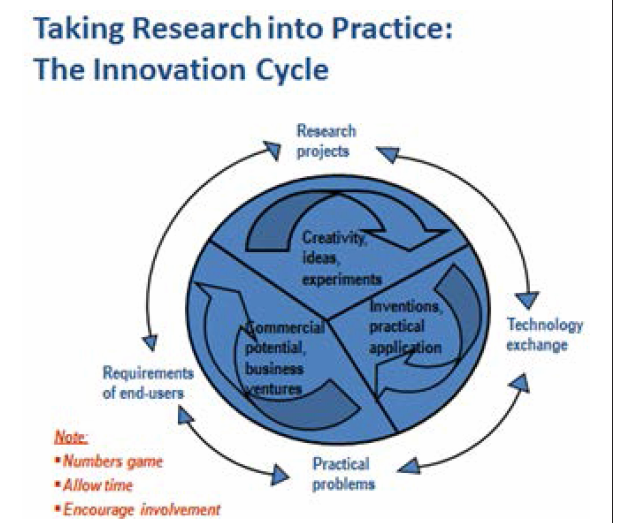
FIGURE 2 | The current innovation cycle for the Water Research Commission (WRC). The WRC’s innovation cycle provides an example of adaptive research similar to the one proposed in the current roadmap for promoting neglected and underutilized crops in South Africa. (Source: 12).